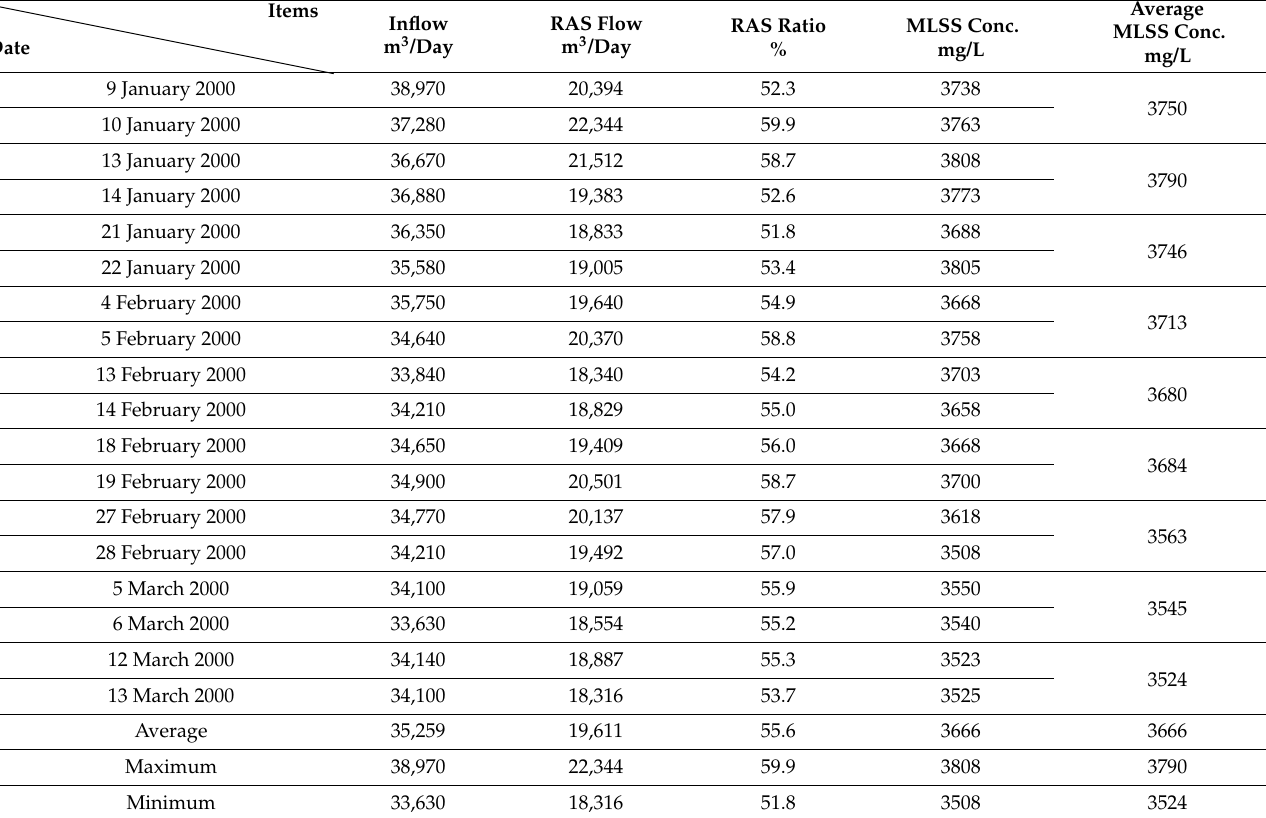
Table 3. Daily inflows, RAS flows, RAS ratios, and MLSS concentrations on respective sampling days at plant